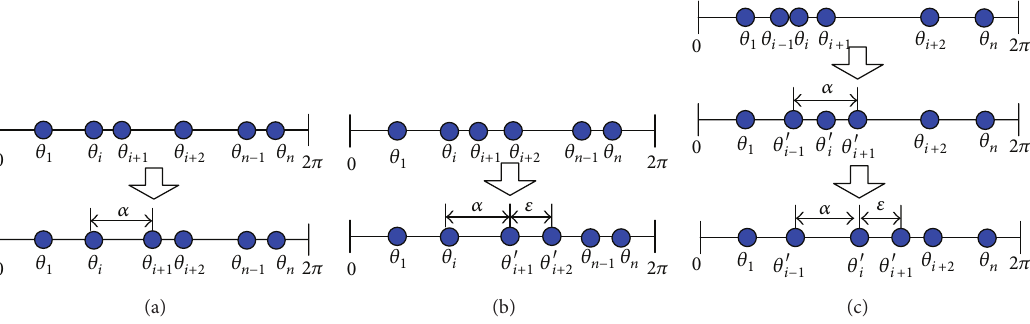
Figure 3: Illustration of sensor redeployment in one working